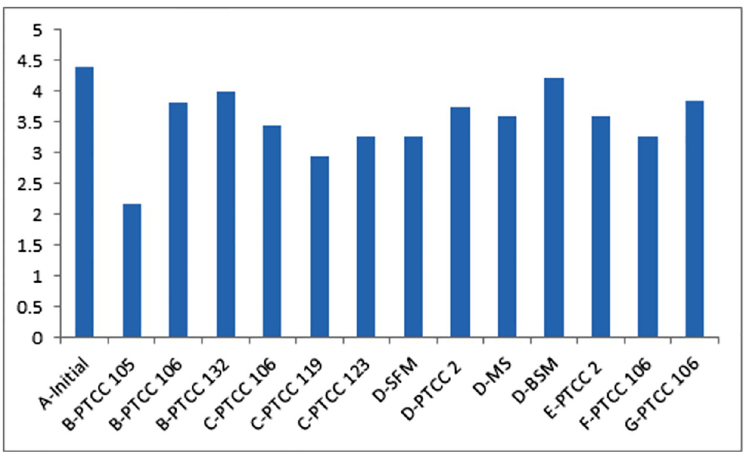
Fig 2. Effect of microorganism treaters and environmental mediums on the BDS of whole sour heavy crude oil. (A) Initial content, (B) Acidothiobacillus ferrooxidans, (C) Acidothiobacillus thioxidans, (D) Rhodococcus erythropolis, (E) Ralstonia eutropha RTCC 77, (F) biomixture (B+C), (G) Isolated colony (yellow form colony).